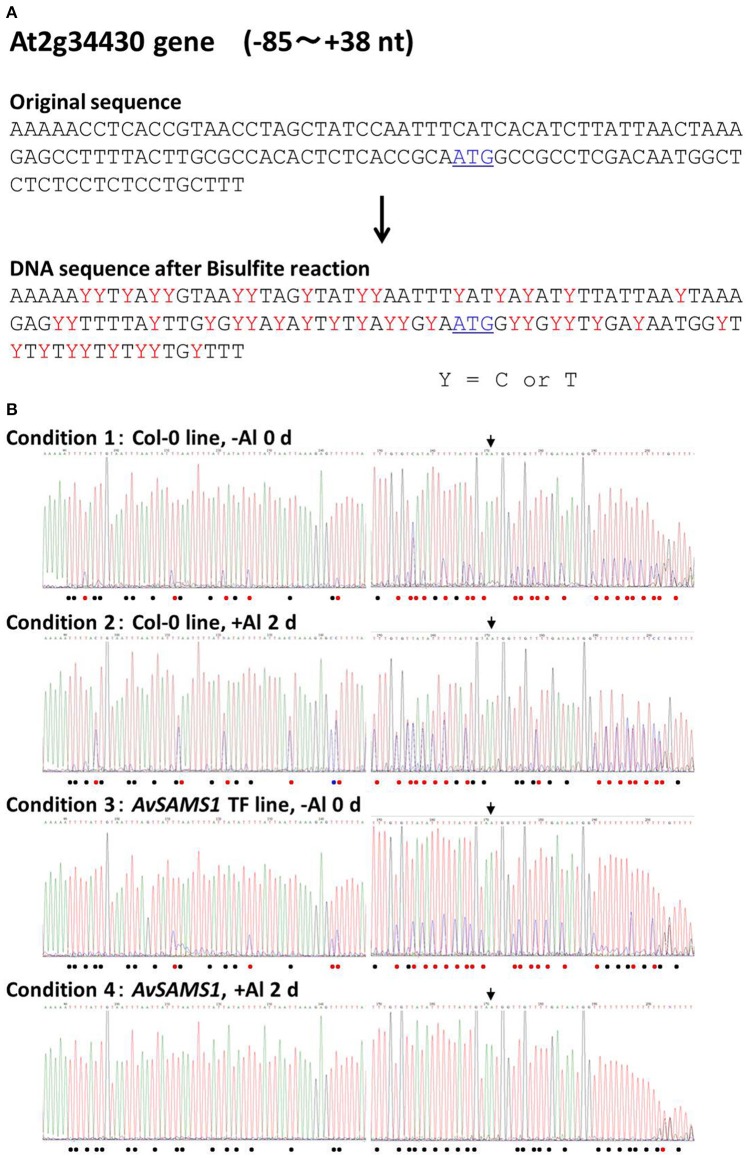
Alteration of Al stress dependent DNA methylation status caused in the Al response gene, At2g34430. (A) Comparison of the original DNA sequence and the deduced DNA sequence of At2g34430 after a bisulphite treatment. Y with red color in the latter sequence represents a mixture of C and T in the sequence, indicating both methylated C (retained as C after bisulphite treatment) and non-methylated C (converted to T by bisulphite treatment). The start codon, ATG, is shown by blue color and with underline. (B) Raw data of DNA sequence patterns of the four templates (Condition 1-4). Template DNAs (genomic DNA) were extracted from the untreated plants (0 days) (Condition 1 and 3) or from the Al treated plants (300 μM Al treatment for 2 days) (condition 2 and 4). Condition 1 and 2, Col-0 ecotype; Condition 3 and 4, the AvSAMS1 TF line. Symbols shown in the bottom of each sequence pattern represented methylation status at C sites. •, Mixture of methylated C and non-methylated C; •, non-methylated C only; •, methylated C only. The limit for defining mixtures was taken as a ratio of >0.1 up to <0.9. Start codon, ATG, is shown by the arrow.